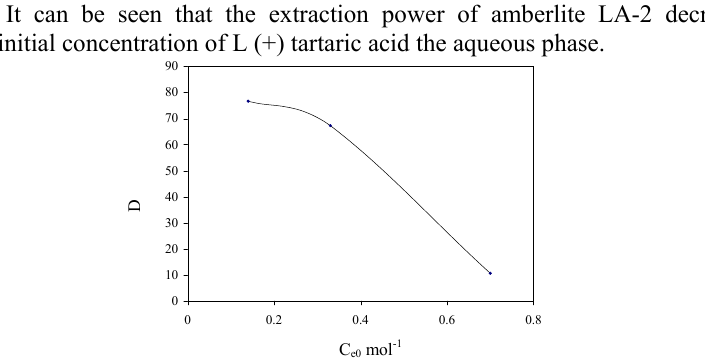
Figure 3. Effect of the initial acid concentration on L(+) tartaric acid distribution between water and amberlite